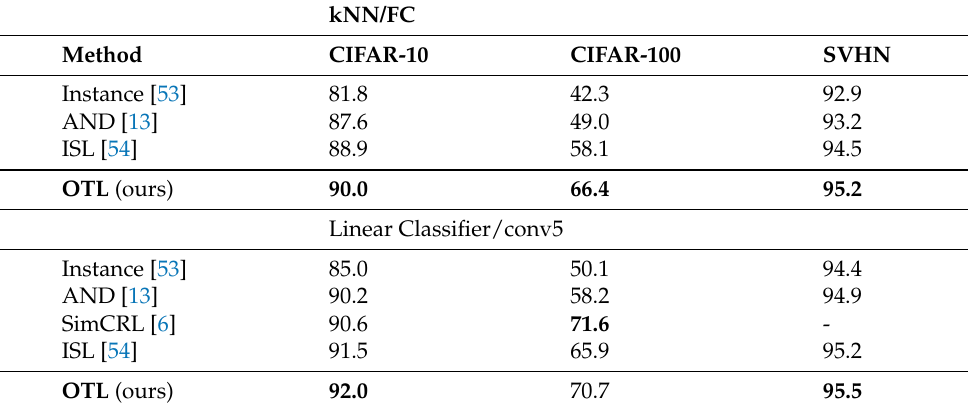
Table 2. Evaluations on ResNet-50 (OTL = Our new method). The best results are highlighted by the